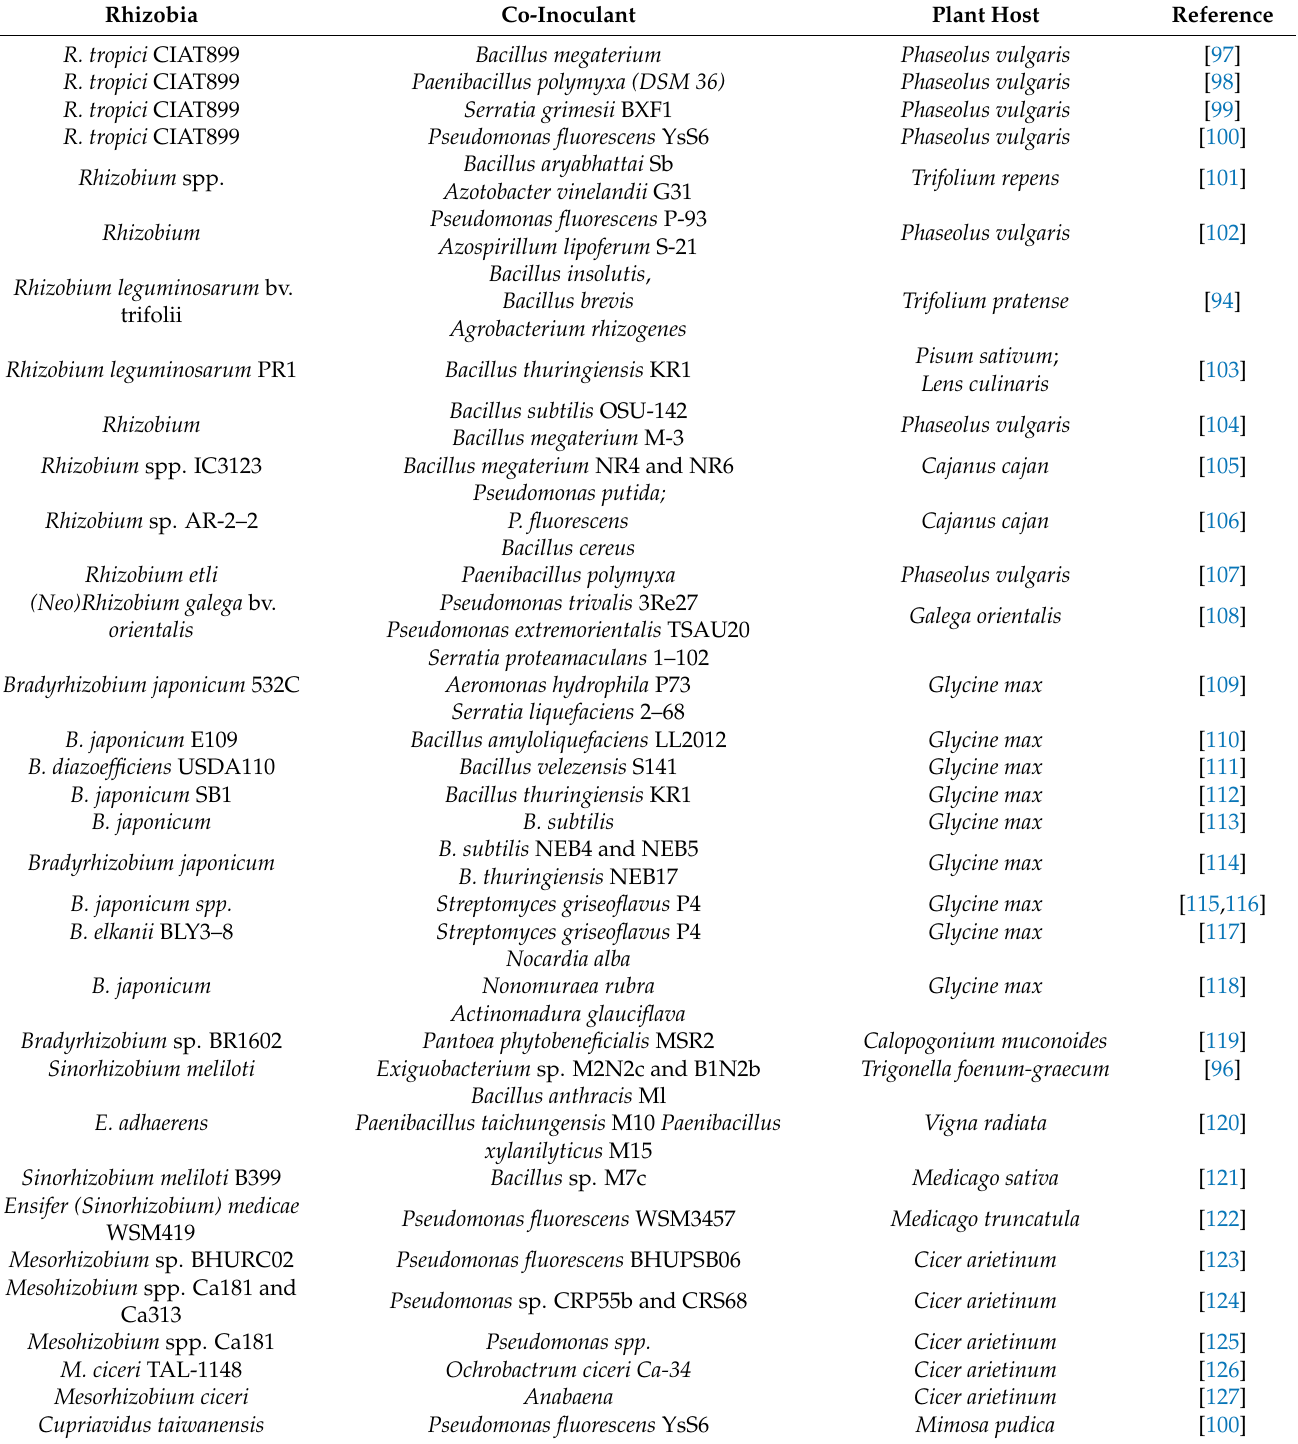
Table 1. Studies reporting the beneficial interactions between consortia of rhizobia and non-rhizobial bacteria and their positive effects in the symbiosis with leguminous